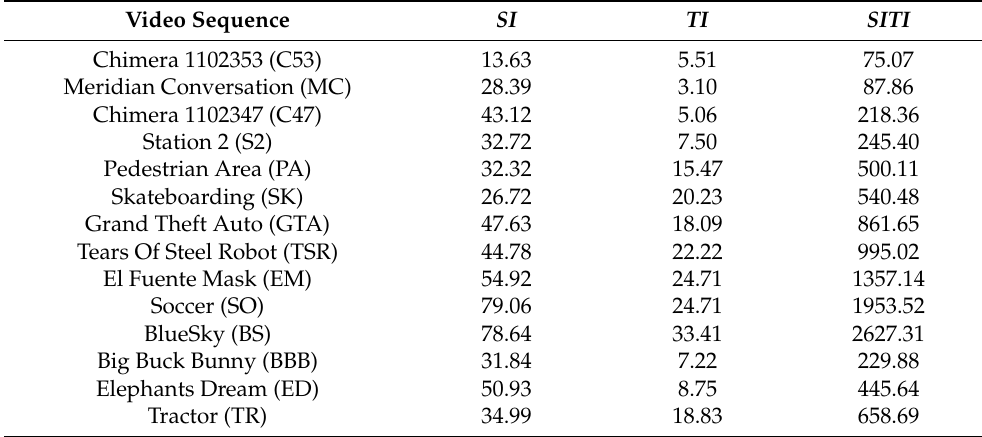
Table 1. Spatial ( SI ) and temporal information ( TI ) of video sequences used for modeling and testing purposes.